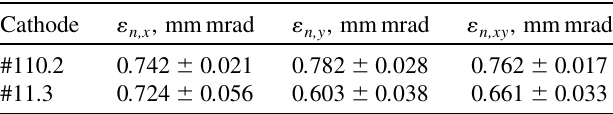
TABLE III. Emittance for a 1 nC beam measured for different